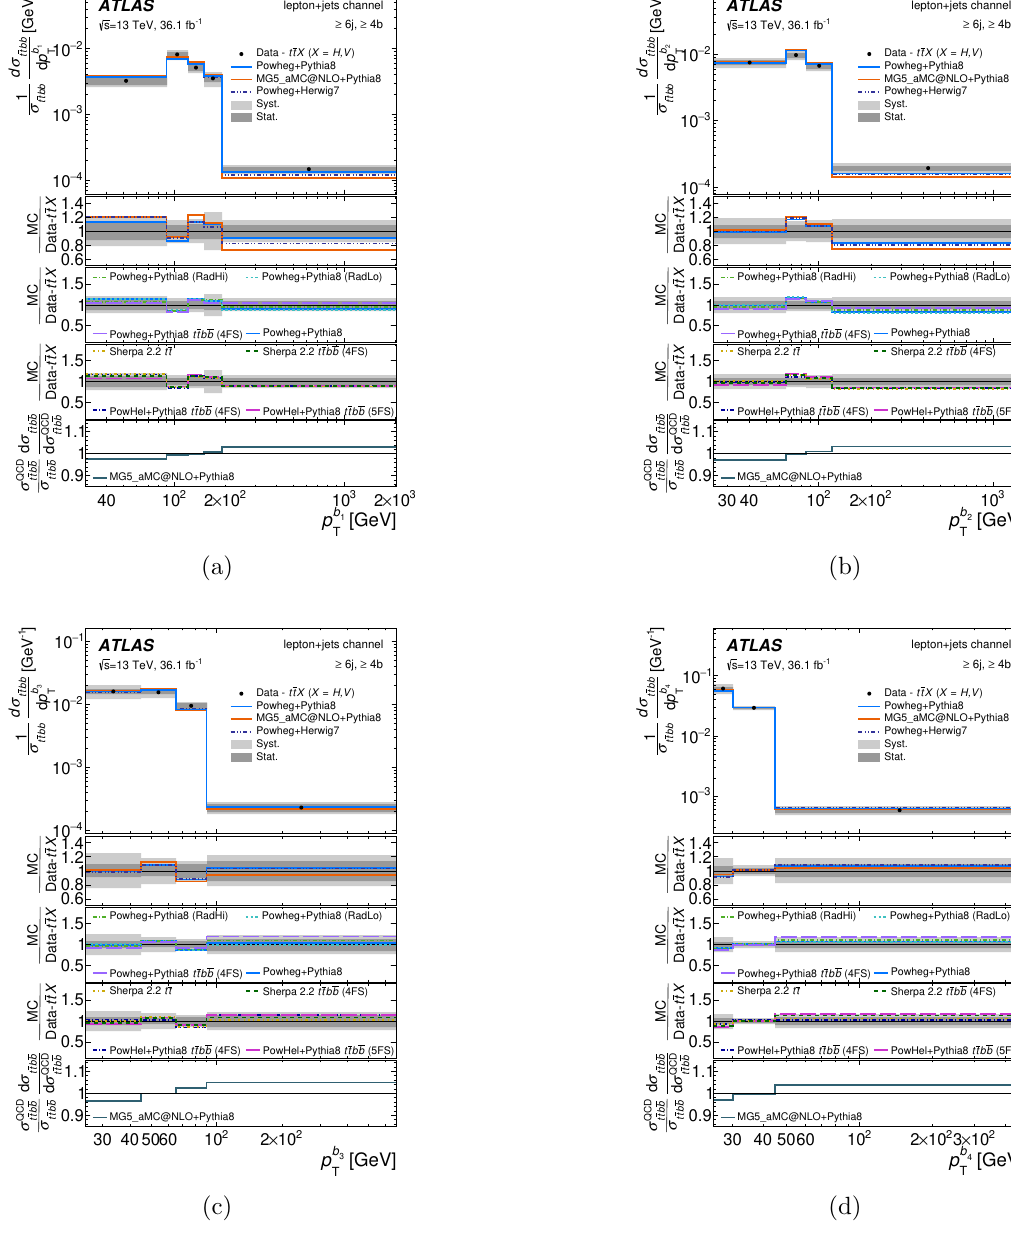
Figure 13. Relative di(cid:11)erential cross-sections as a function of b -jets p T for p T -ordered b -jets in events with at least four b -jets in the lepton + jets channel compared with various MC generators. The t (cid:22) tH and t (cid:22) tV contributions are subtracted from data. (a) leading b -jet p T , (b) sub-leading b -jet p T , (c) third-leading b -jet p T , (d) fourth-leading b -jet p T . Four ratio panels are shown, the (cid:12)rst three of which show the ratios of various predictions to data. The last panel shows the ratio of predictions of normalised di(cid:11)erential cross-sections from MadGraph5 aMC@NLO+ Pythia 8 including (numerator) and not including (denominator) the contributions from t (cid:22) tV and t (cid:22) tH pro- duction. Uncertainty bands represent the statistical and total systematic uncertainties as described in section 8. Events with b -jets p T values outside the axis range are not included in the plot.